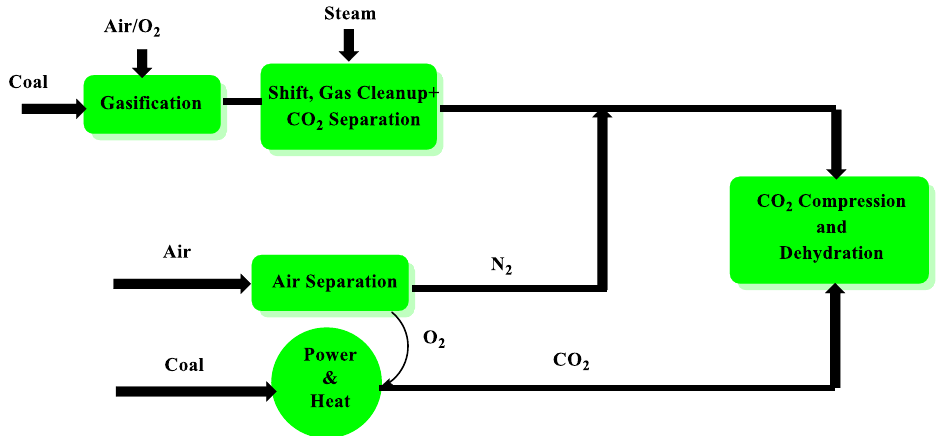
Figure 3. Oxyfuel-combustion capture process.